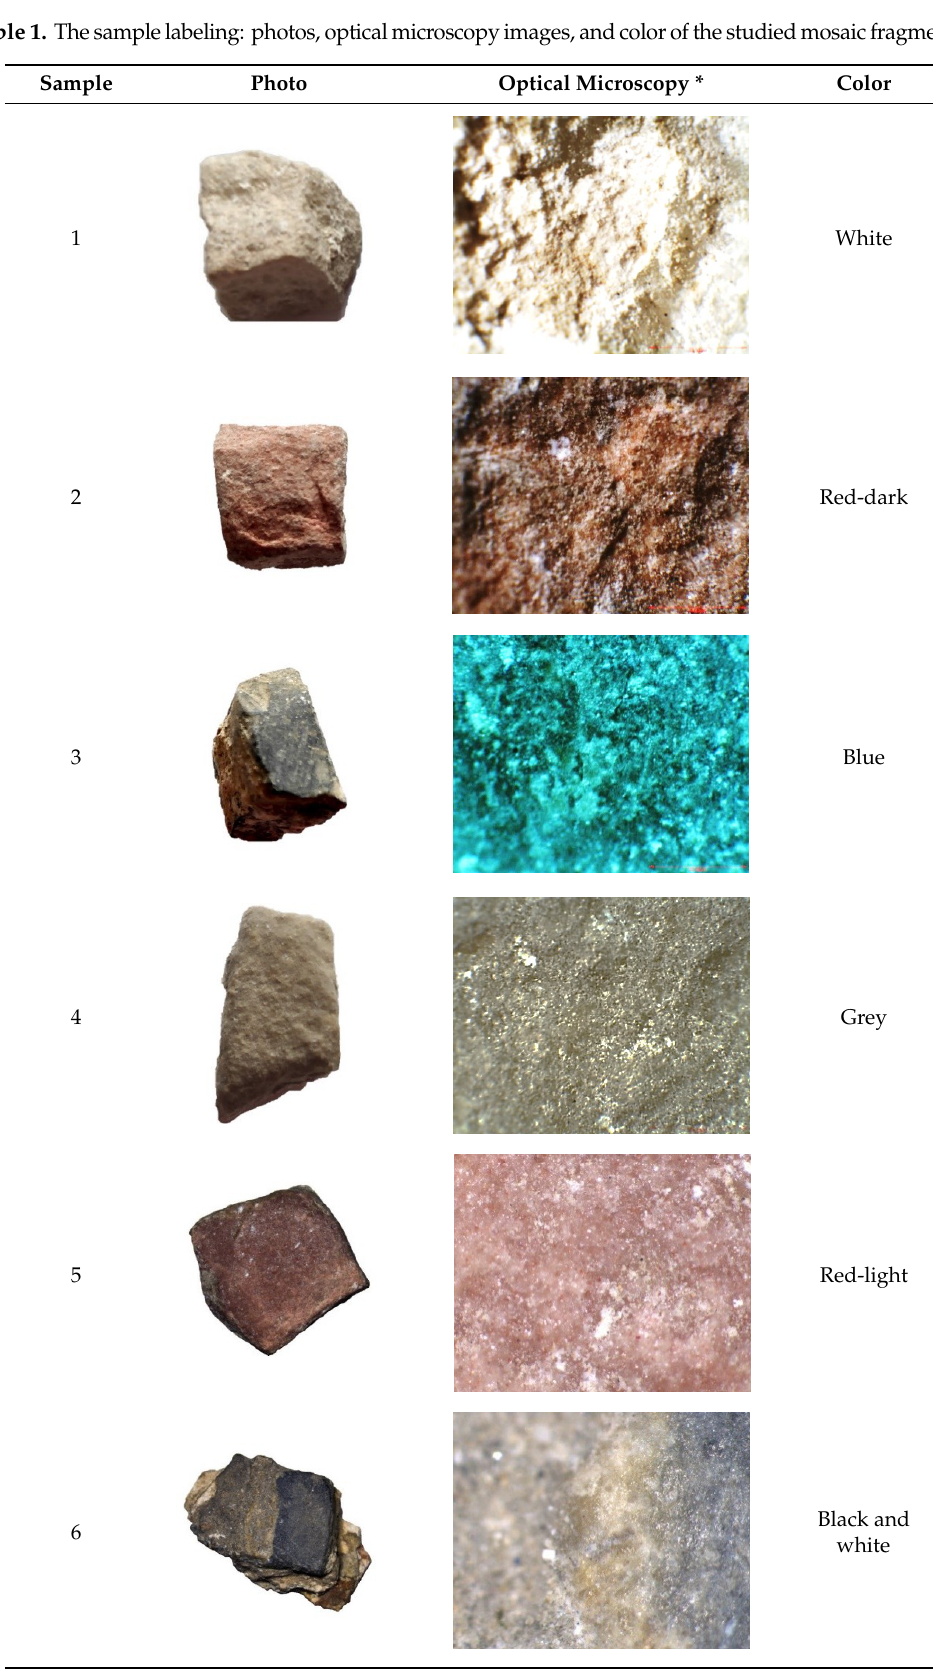
* Optical microscopy images were recorded at 40×